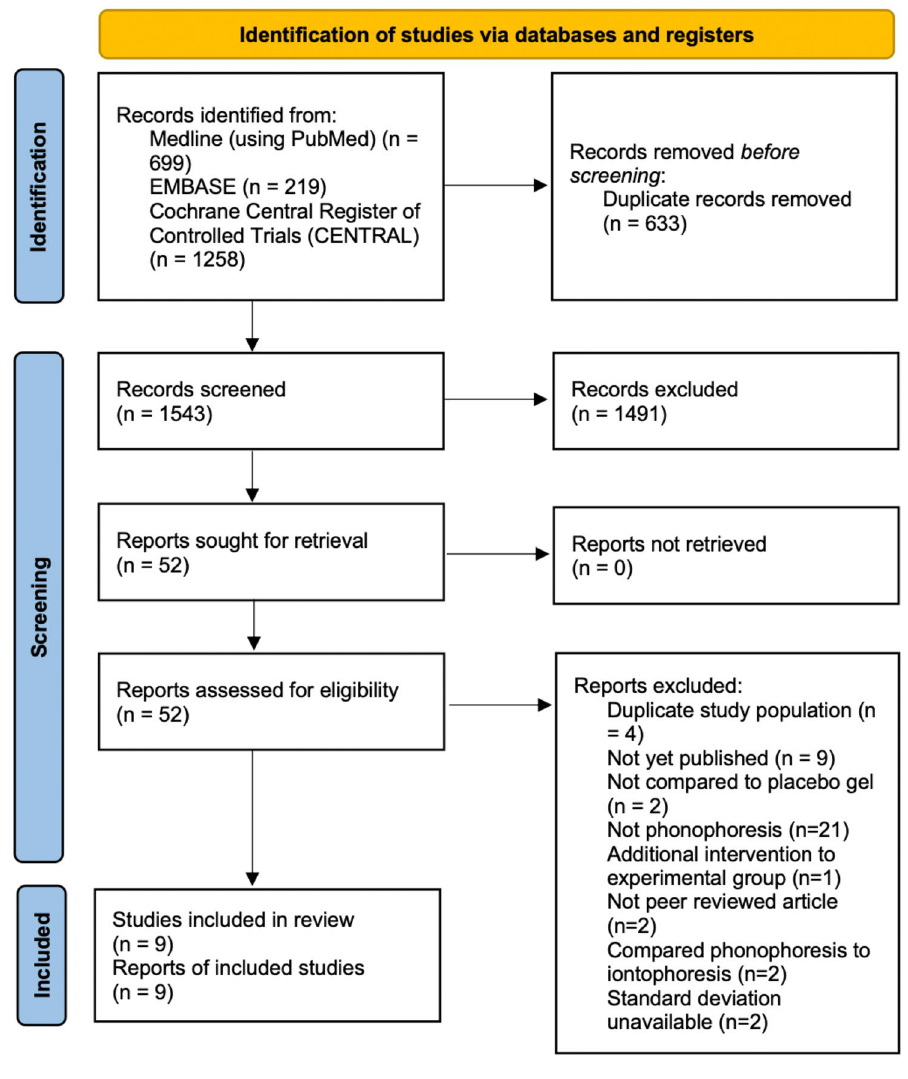
Figure 1. Flowchart of article